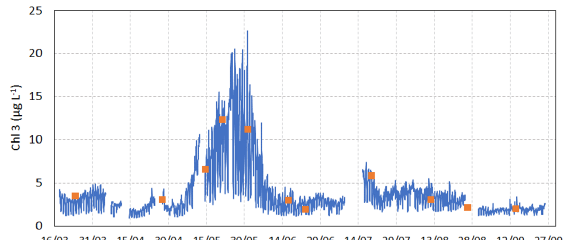
Figure 3: Sensor data (hourly average) of chlorophyll-a (2.5 m depth) in 2021. Orange dots: chlorophyll-a measured in the lab- oratory on grab